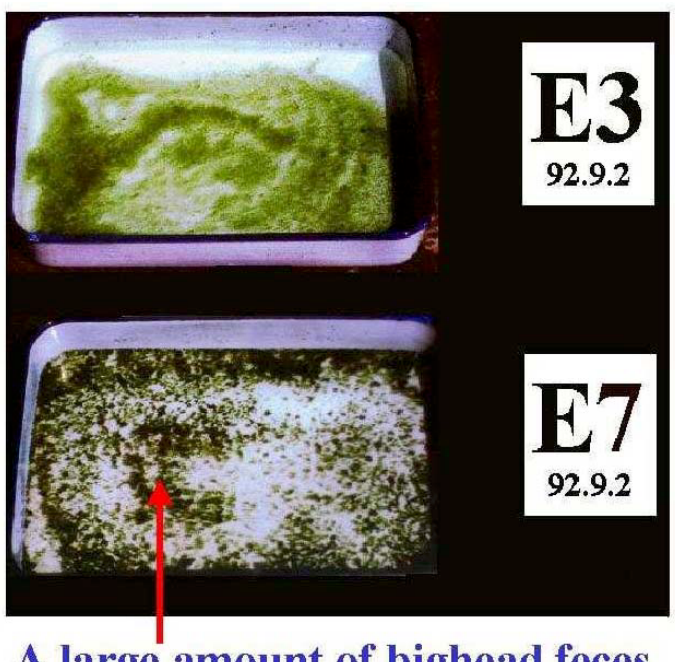
FIGURE 12. Microcystis blooms collected from the surface of enclosures 3 and 7 on September 2. On August 21, 932 g of bighead carp was stocked into enclosure 7, while 561 g of grass carp was stocked into enclosure